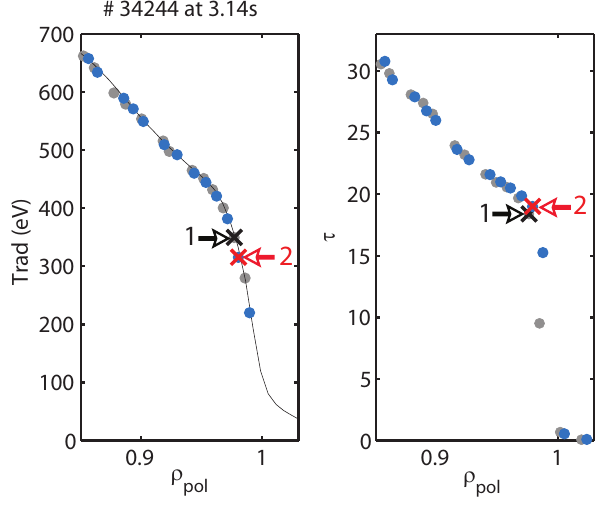
Figure 5. a) Modeled T rad profile of the ECE system shown against warm resonances of respective channels. The dark gray circles correspond to a case with background density profile (dis- played as black solid line in figure 3), and the blue circles cor- respond to a case with added Gaussian (dashed black profile in figure 3). The channel analyzed in this manuscript is labeled as 1 for the case without perturbation, and 2 with perturbation present. b) Optical depth for ECE channels for case 1 and 2, marked as gray and blue circles,